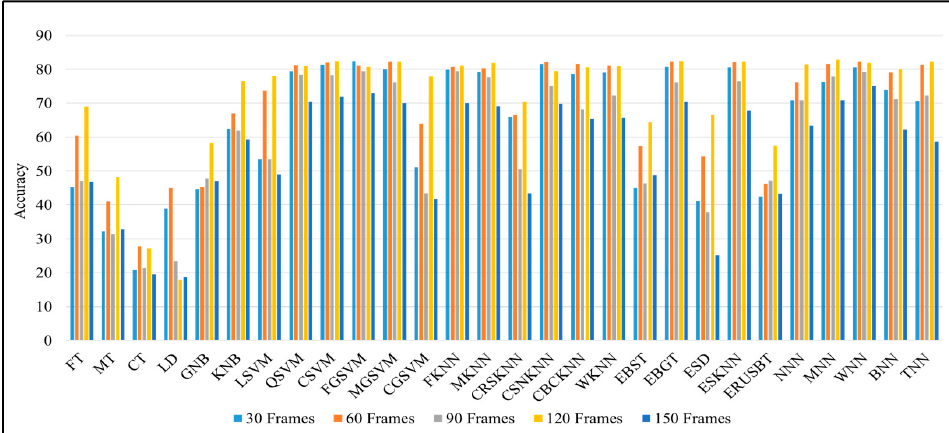
Figure 6. Comparison graph of different machine learning classifiers various types of sequences.